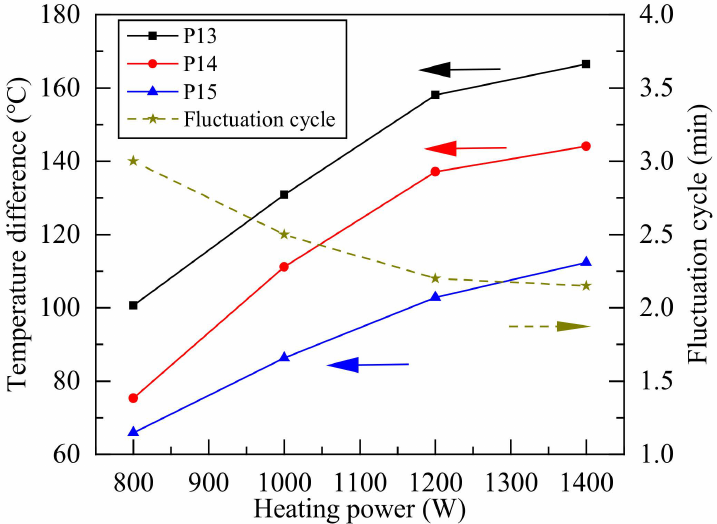
Figure 8. Average temperature difference and fluctuation cycle of condenser section during geyser